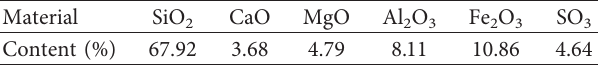
Table 3: Chemical composition of iron tailing sand.